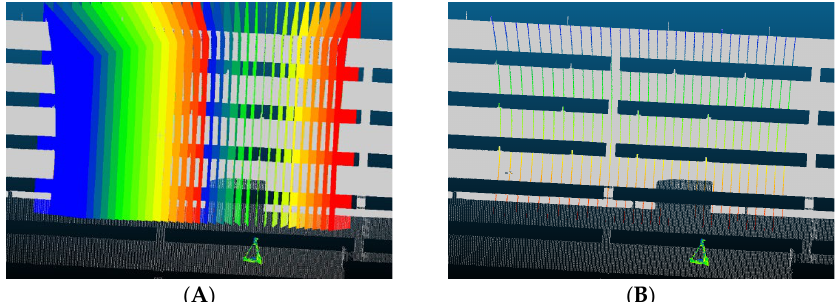
Figure 11. Velodyne ® HDL–32E with individual scanner and receiver pairs (32 total) plotted along central axis with focal point locations plotted for every 0.01° of rotation ( A ) with and ( B ) without the scanner point cloud.